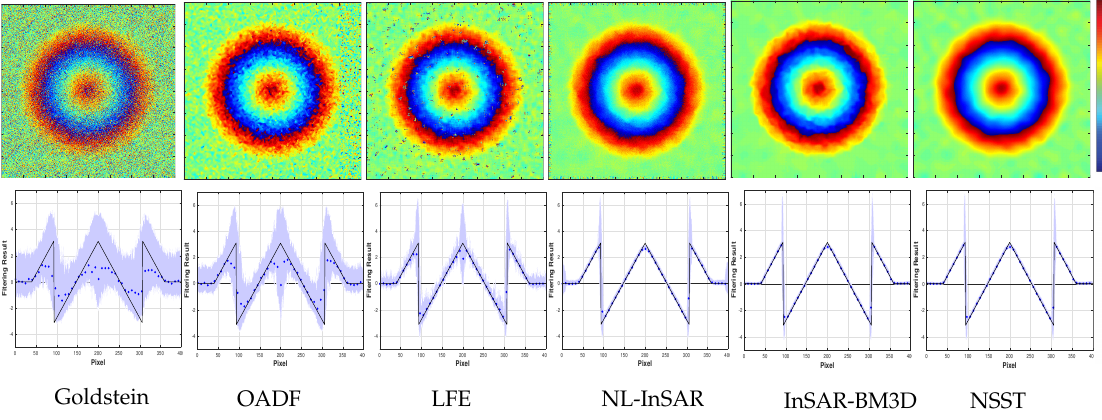
Figure 8. The filter results of the interferogram generated by a cone with coherence of 0.5 (top) and the statistical result of pixels at the center row (bottom, the black solid line is the true value; the blue dotted line denotes the mean of 100 experiments; the pale blue shadow is the range of three times standard deviation near the mean.).